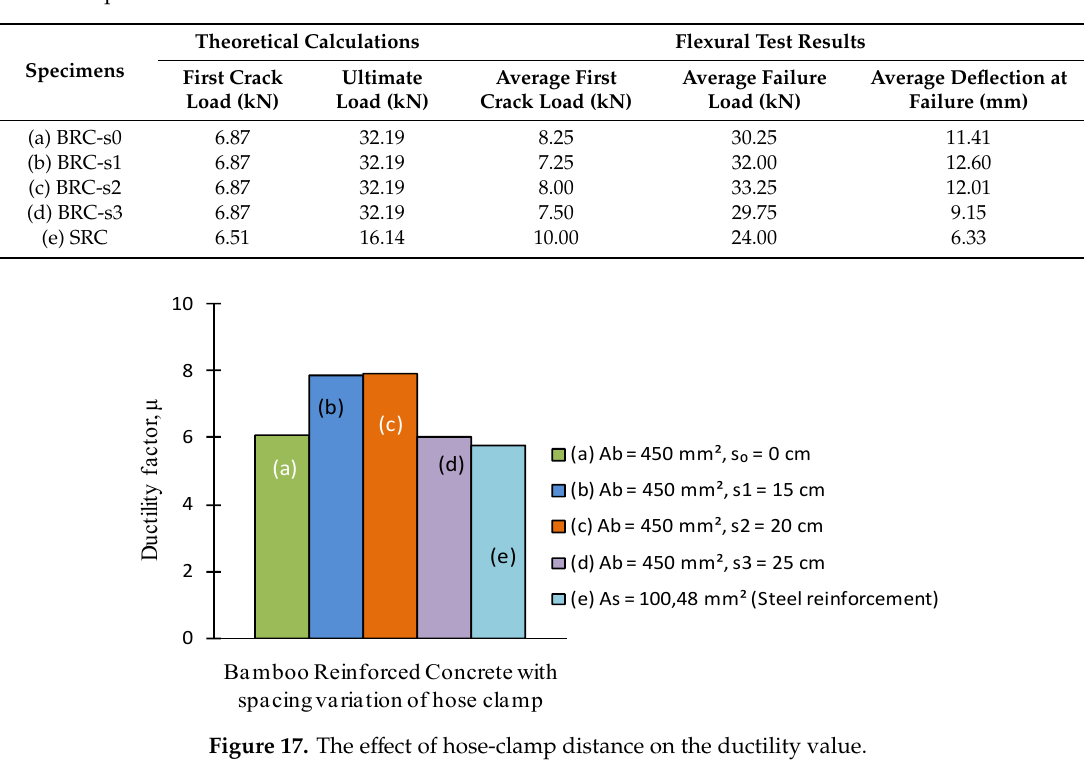
Table 1. The value of the average initial crack loads and ultimate loads based on theoretical calculations and experimental.